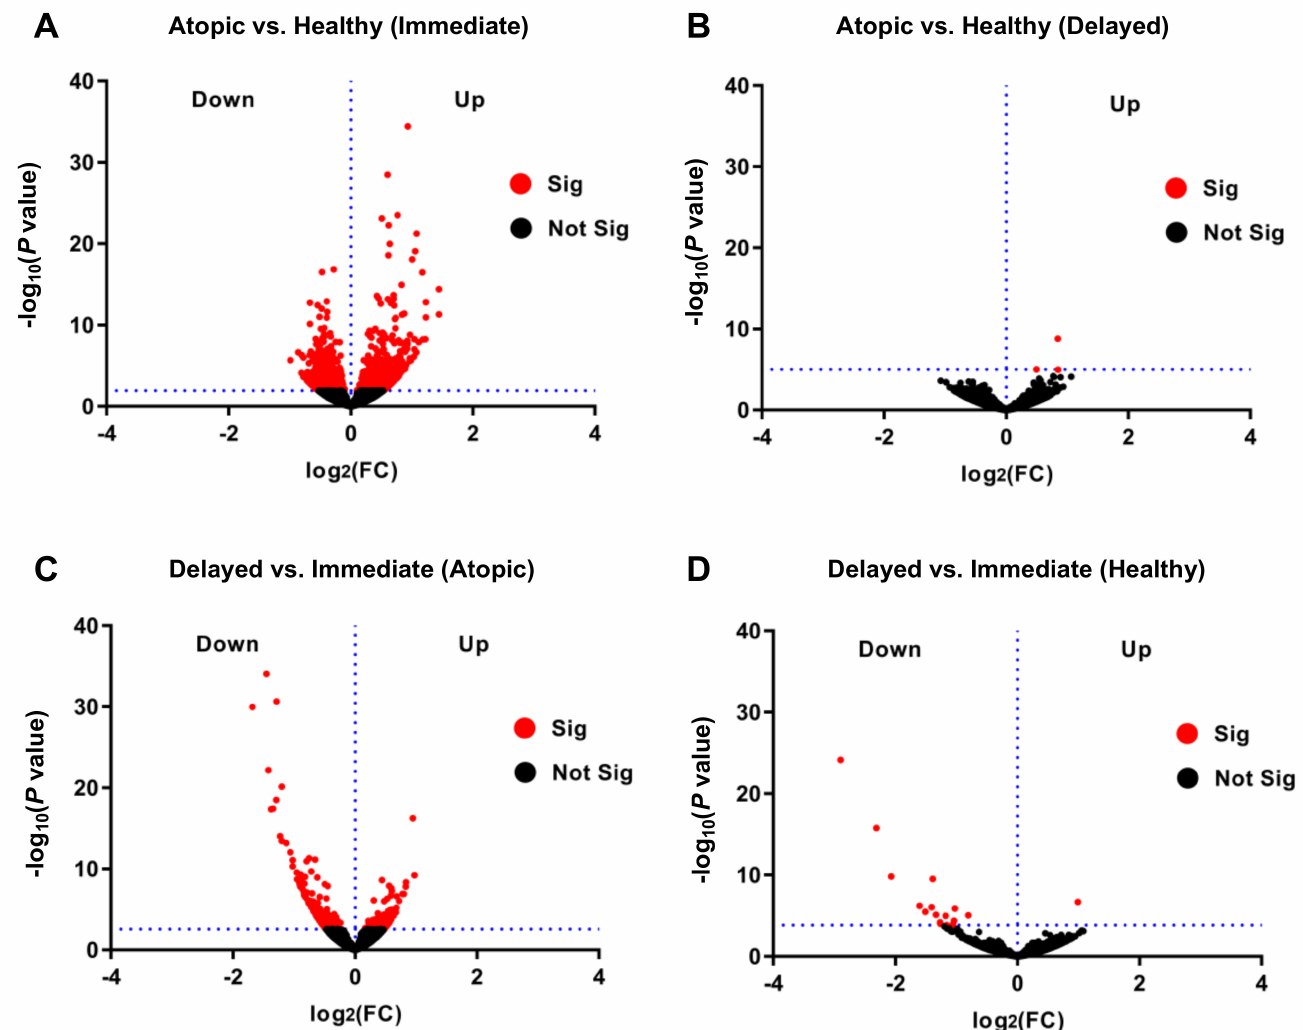
Figure 2. Differential transcriptome profiles in immediately versus delayed processed CD4 + T-cells from atopic and healthy subjects. Volcano plots presenting differentially regulated genes of ( A ) immediately and ( B ) delayed processed blood-derived CD4 + T-cells of atopic versus healthy subjects, and delayed versus immediately processed cells of ( C ) atopic subjects and ( D ) healthy subjects, all with significance threshold at FDR <